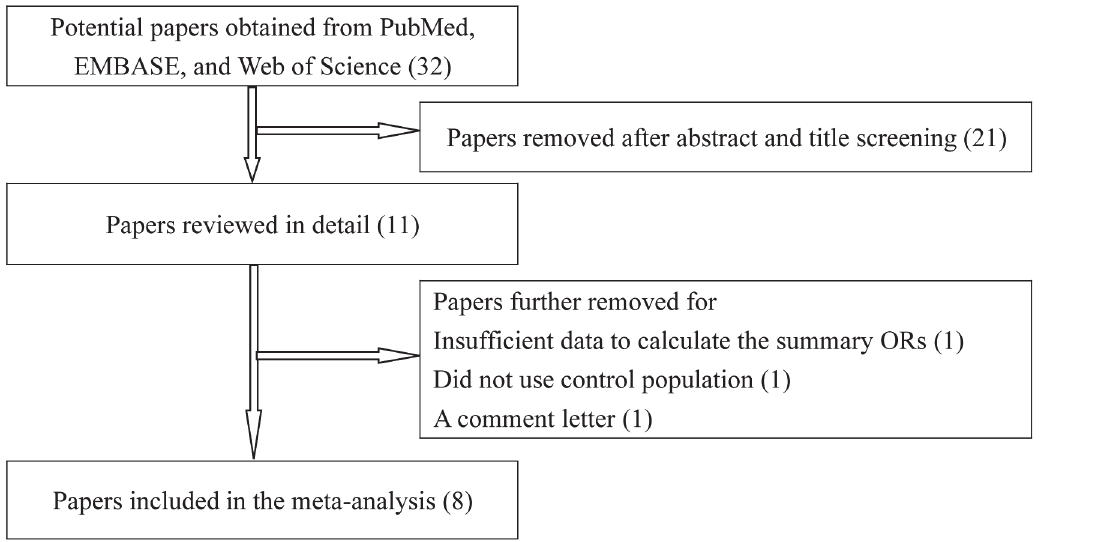
Fig 1. Flow diagram of included studies for this